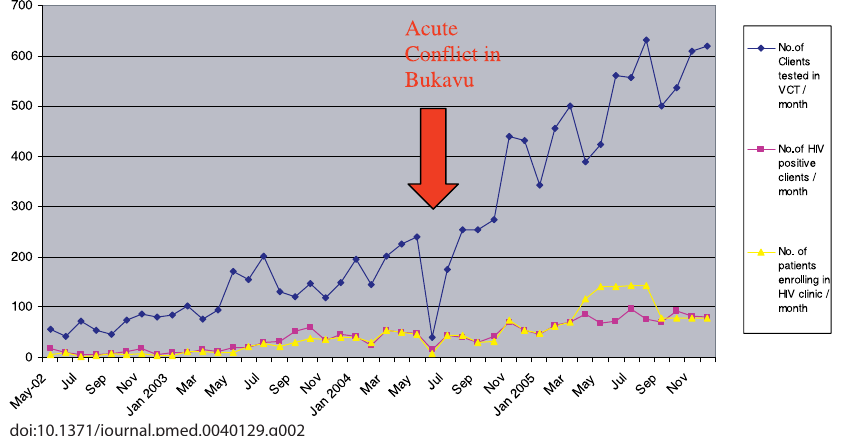
Figure 2. Monthly Number of People Undergoing VCT, Testing HIV Positive, and Enrolling in the HIV